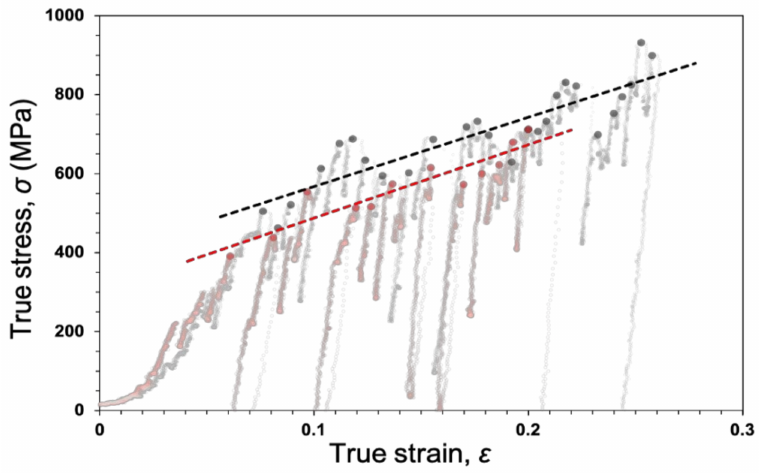
Figure 9. Plot of the stresses against the strain immediately before the stress drop, meaning the start point of the strain burst, for the as-FIB (black) and the post-annealed (red) Al